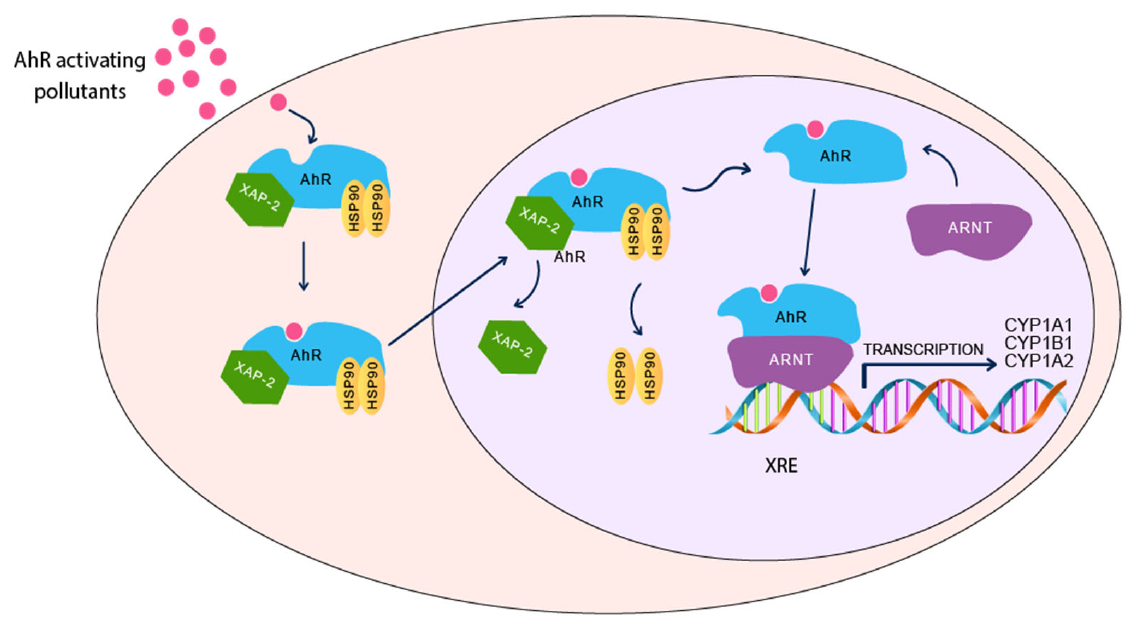
Figure 1. AhR/CYP1 activation signaling pathway .